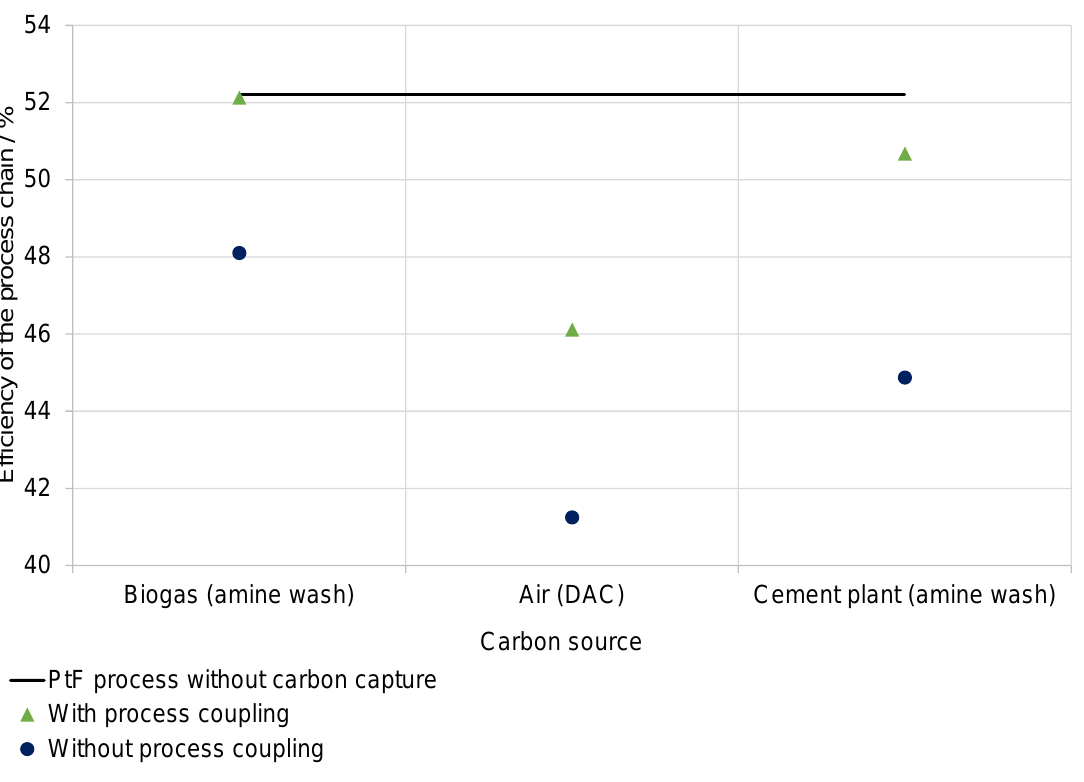
Figure 14. Coupling of the modeled synthesis with CO 2 capture technologies.